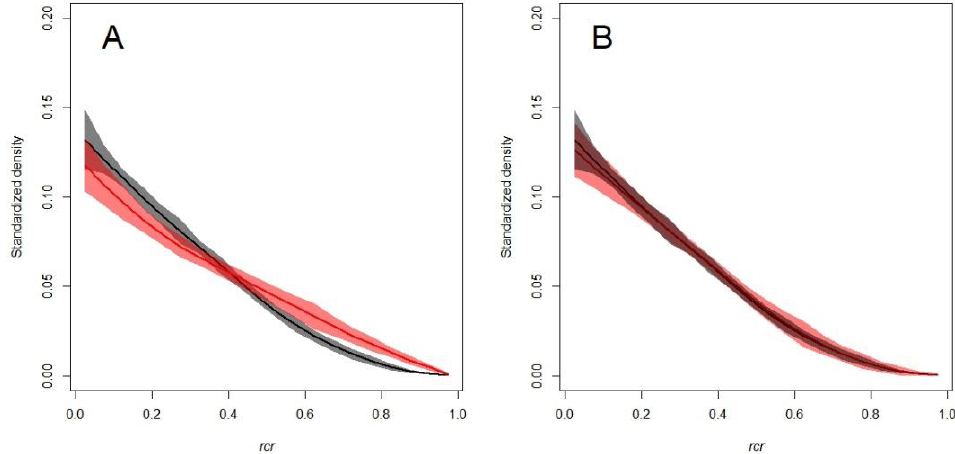
Figure 10. Comparison of the empirical horizontal branch biomass distribution (black) with ( A ) the original Standardized Composite Histogram obtained from Terrestrial Laser Scanning data (red) and ( B ) the Standardized Composite Histogram obtained by TLS data adjusted with the empirical data. The solid lines represent the mean local regression trends (smoothing span α = 0.75) and the shaded areas represent the 95% confidence intervals. Overall, the results indicate that the proposed SCH metric may be used as a proxy for the empirical branch biomass distribution, albeit adjustments were